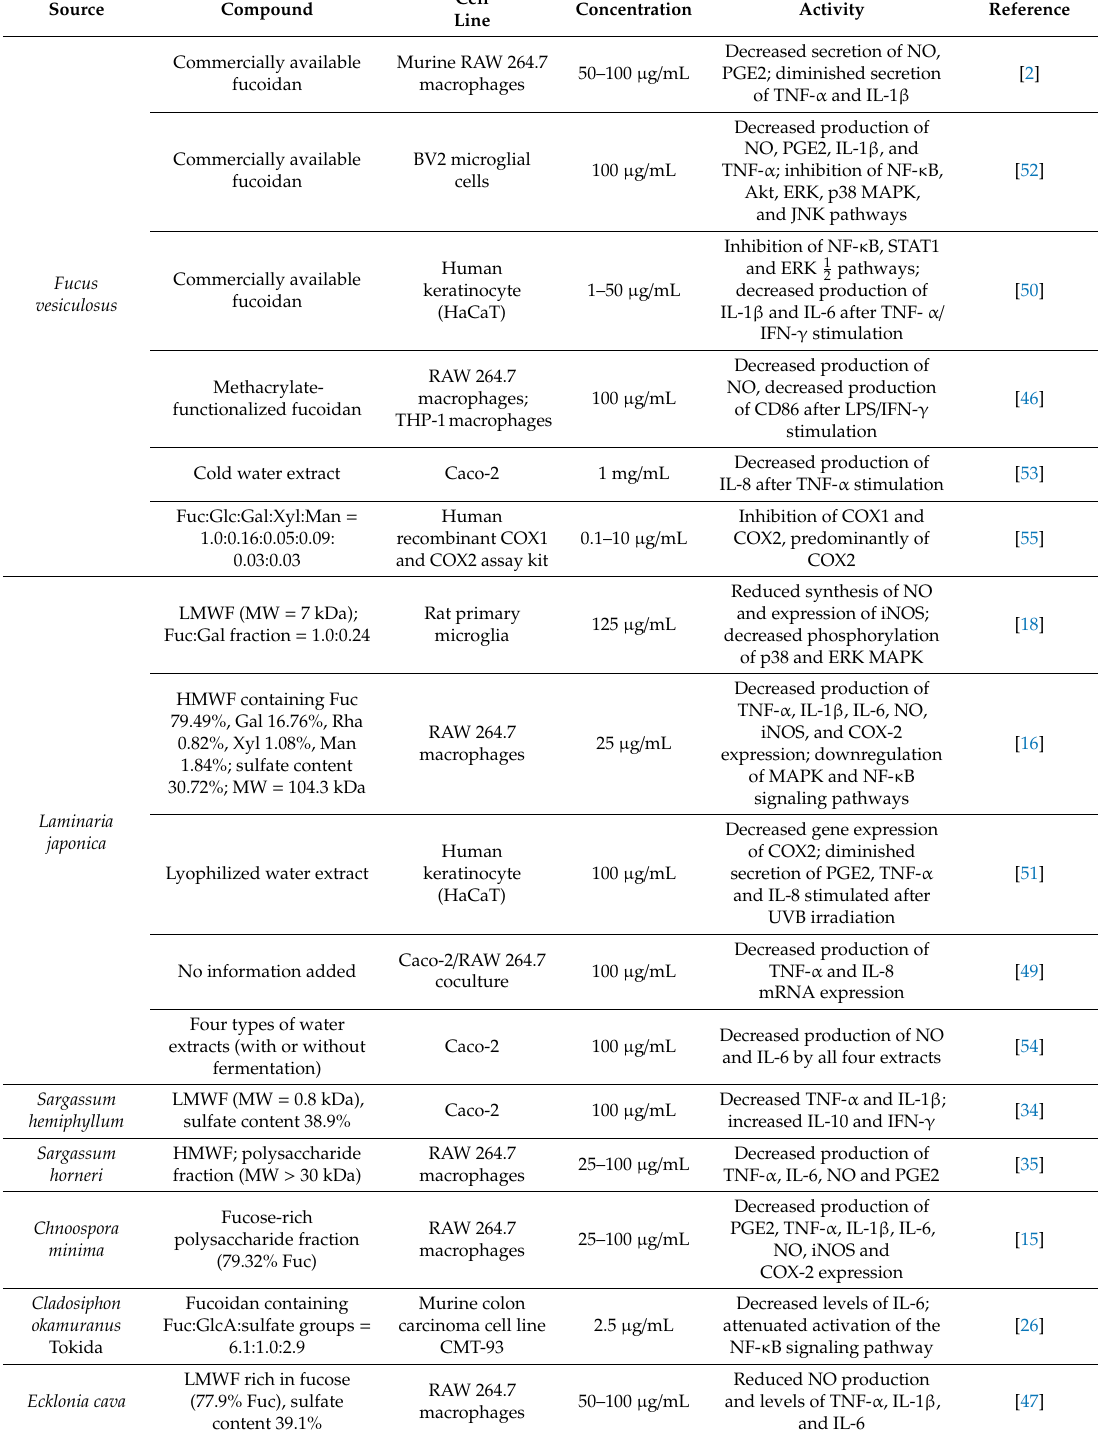
Table 1. In vitro anti-inflammatory activity of fucoidan. Results were observed after LPS-stimulation of the cell